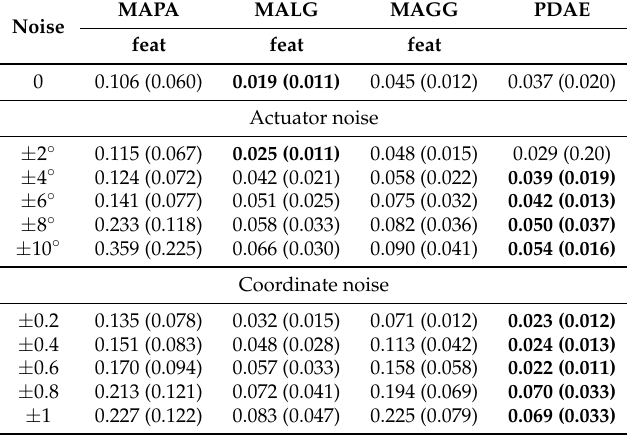
Table 4. 3D-3D manifold alignment: Shown is the alignment error ∆ with the standard deviation for each level of the noise. The lowest ∆ or closest alignment of each row is highlighted in